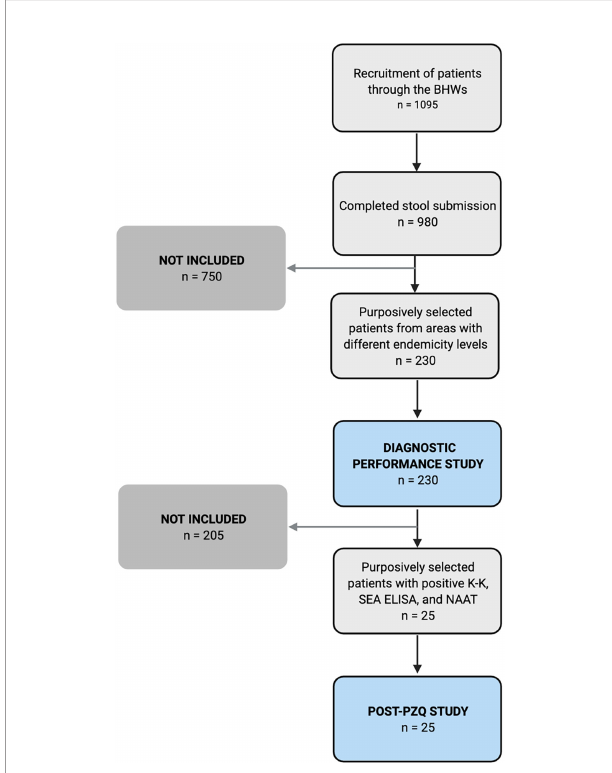
FIGURE 2 | Recruitment of participants for the diagnostic performance (n = 230) and post-treatment studies (n =